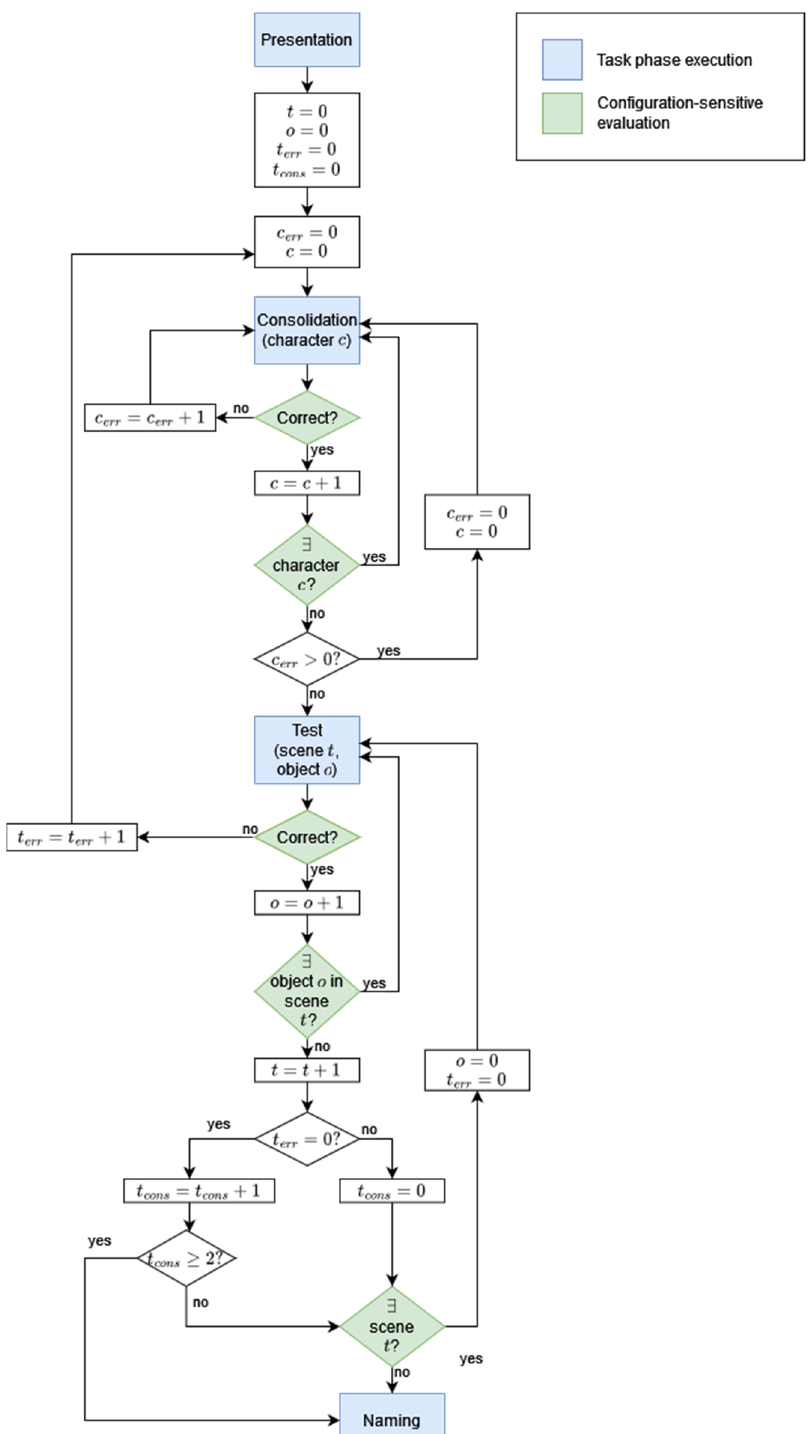
Figure 3. Flow diagram of the DNWL task.